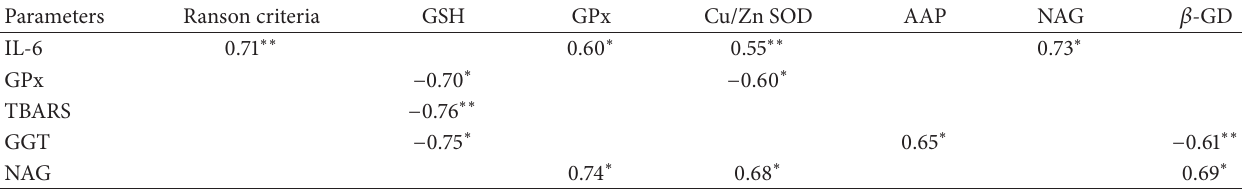
Table 5: Result of Spearman correlations for examined parameters in patients with AP.